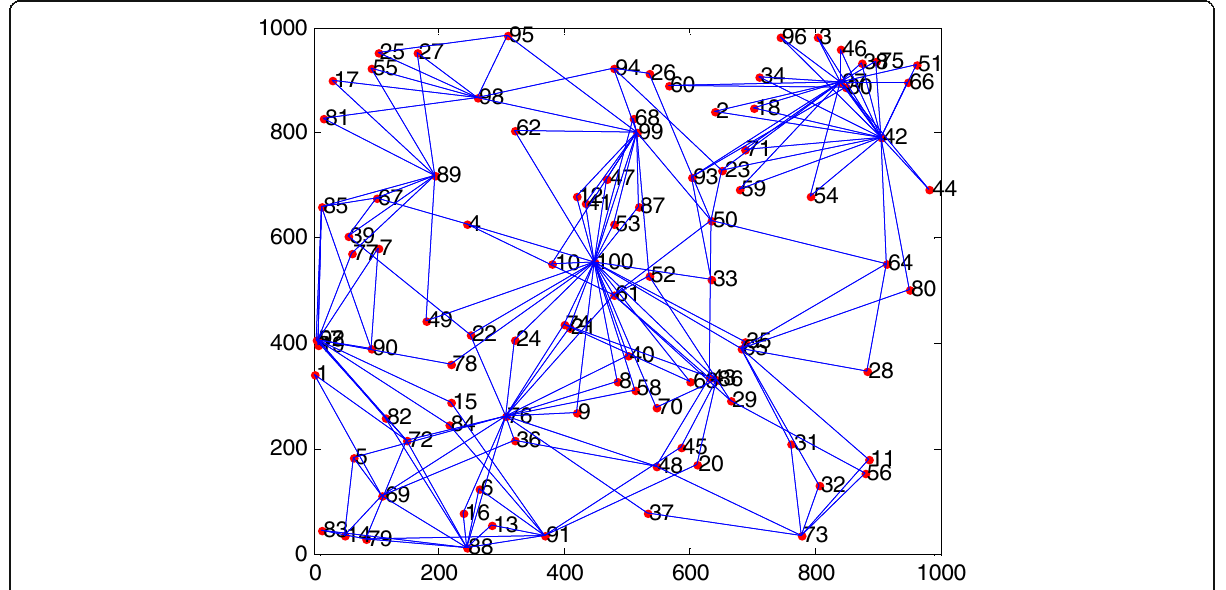
Fig. 3 Topology of the network. BA scale-free network topology, where 100 nodes are distributed in a square area of 1000 m × 1000